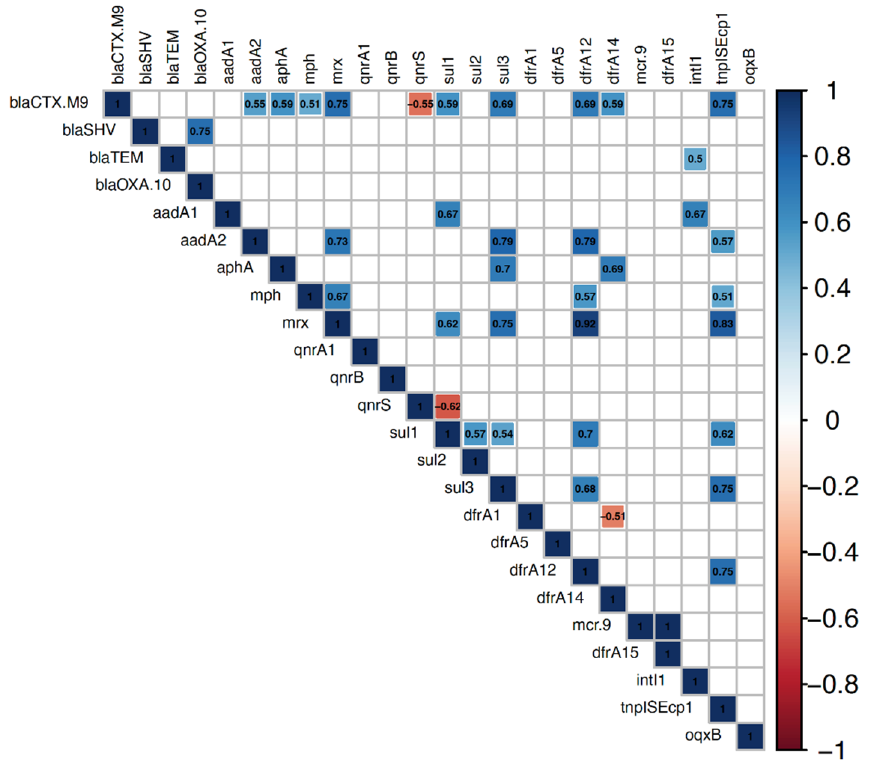
Figure 1. Correlation analysis determines the associations between resistance genes among E. coli isolates from turkeys. The blue and red boxes indicate positive and negative correlations, respectively. The strength of color corresponds to the numerical value of the correlation coefficient ( r ). Significance was calculated at p < 0.05, and boxes with non ‐ significant correlations were left blank.